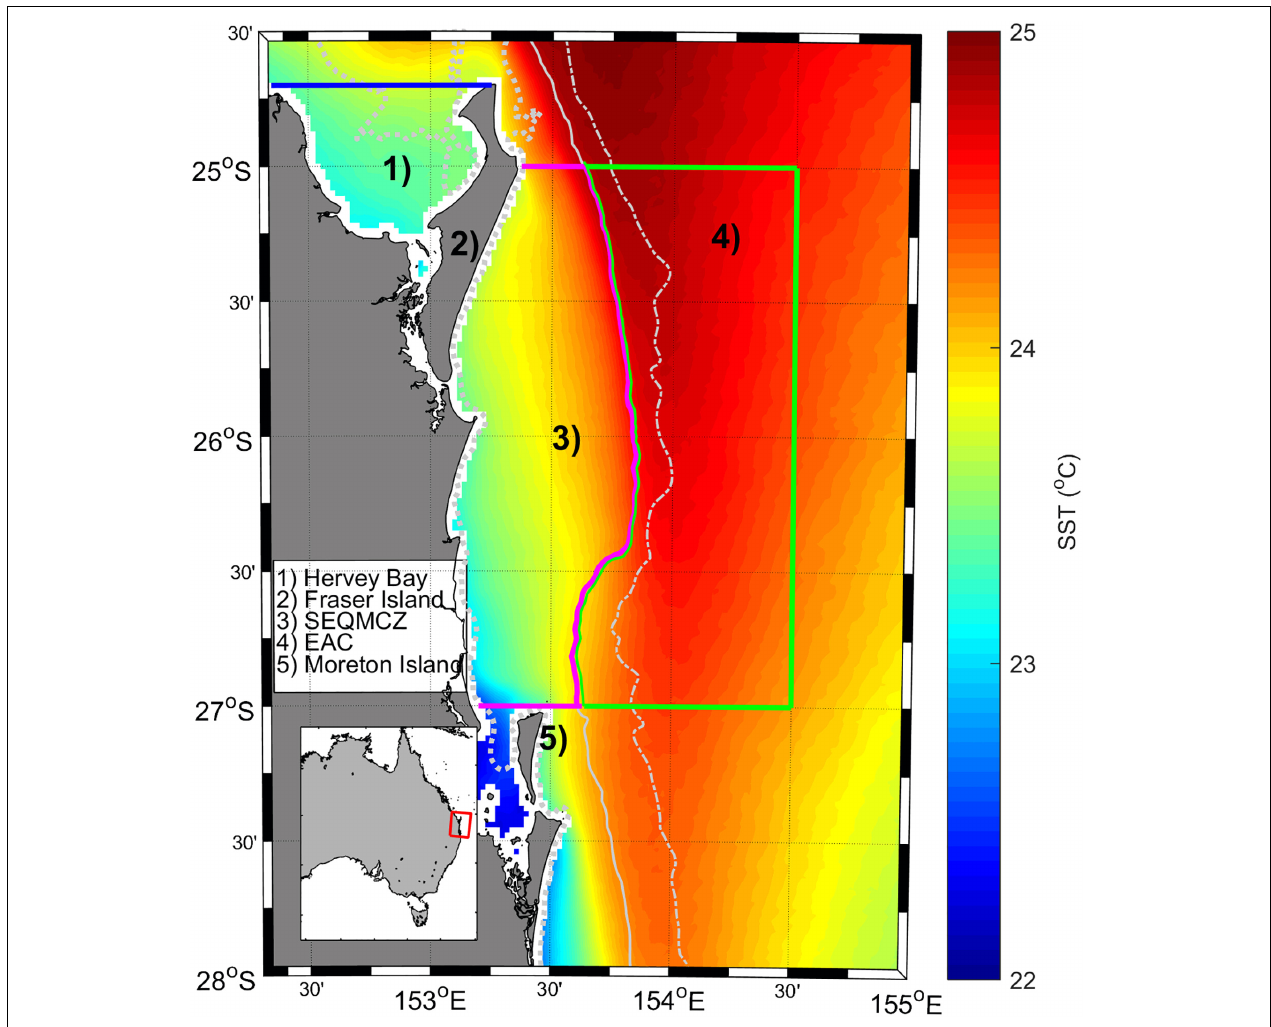
FIGURE 1 | Map of the study site off southeast Queensland, Australia, with 20 m (dotted), 150 m (dashed), and 1,000 m (solid) isobaths indicated. Shading represents the mean SST for the years 1993 to 2016. The blue line restrains the area representing Hervey Bay at 24.7 ◦ S (1). The area marked in pink represents the SEQMCZ (3). Green lines show the boundaries of the area used to represent the EAC influenced off shelf region